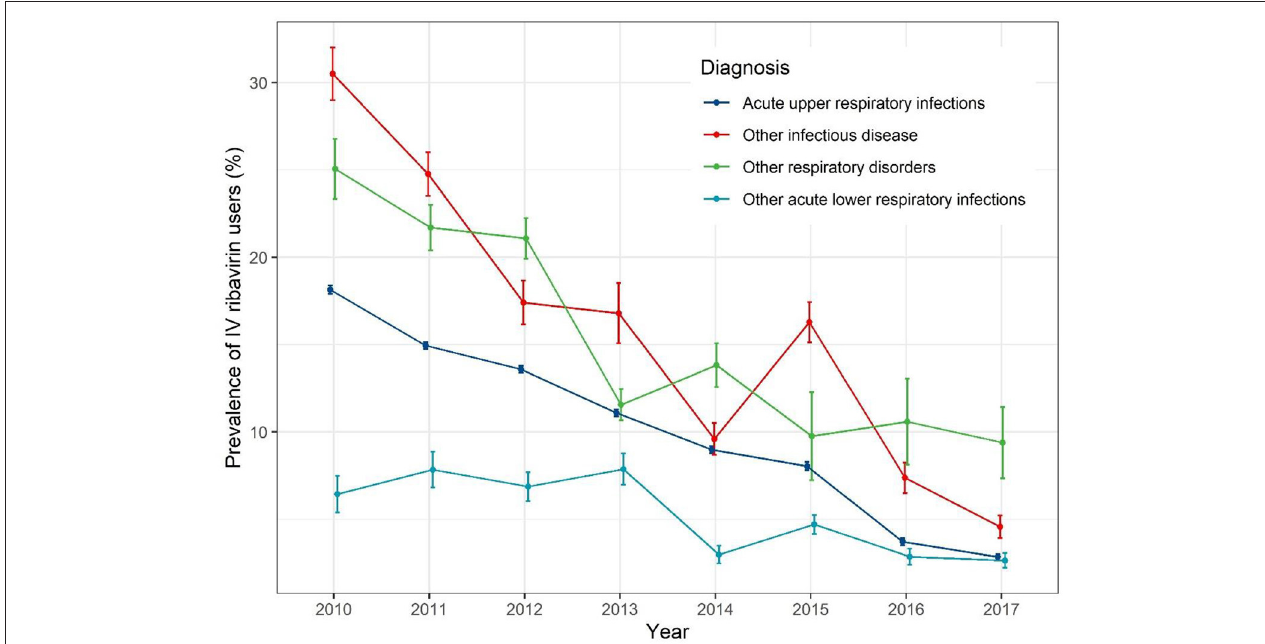
FIGURE 4 | Trends of prevalence of IV ribavirin prescription for different